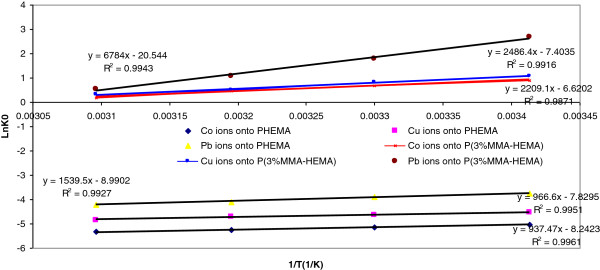
lnK0 vs. 1/T plot.